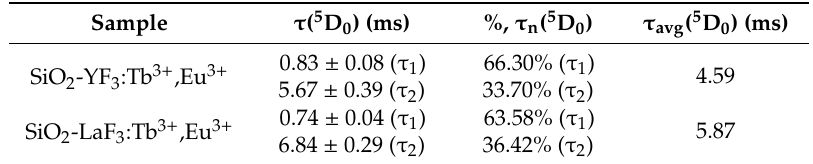
Table 3. Luminescence lifetimes of the 5 D 0 state of Eu 3 + and their contributions for fabricated glass-ceramics.